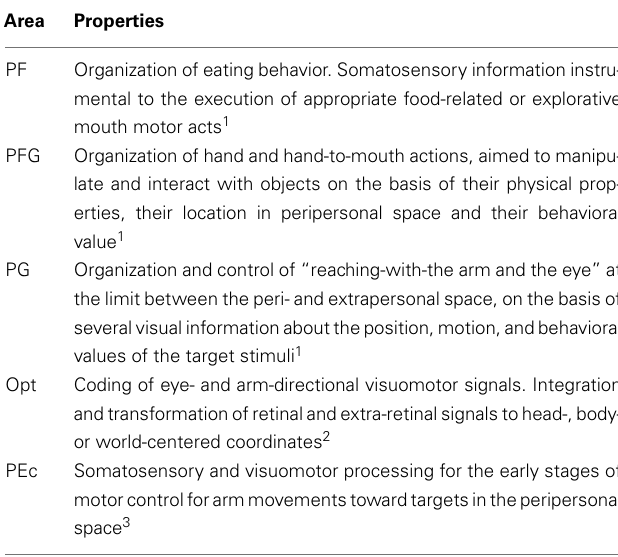
Table 1 | Functional properties of the injected